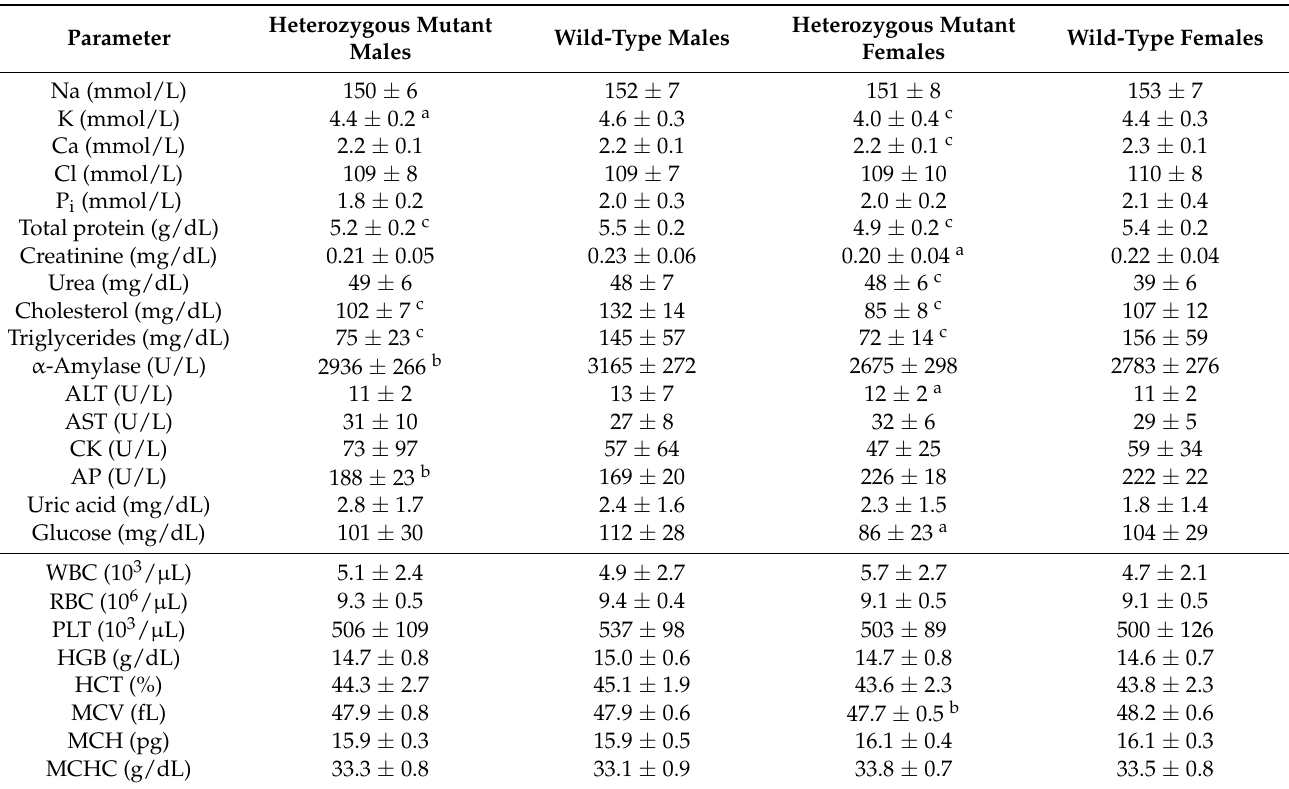
Table 1. Clinical chemical and hematological analysis of line Trpc7 K810Stop